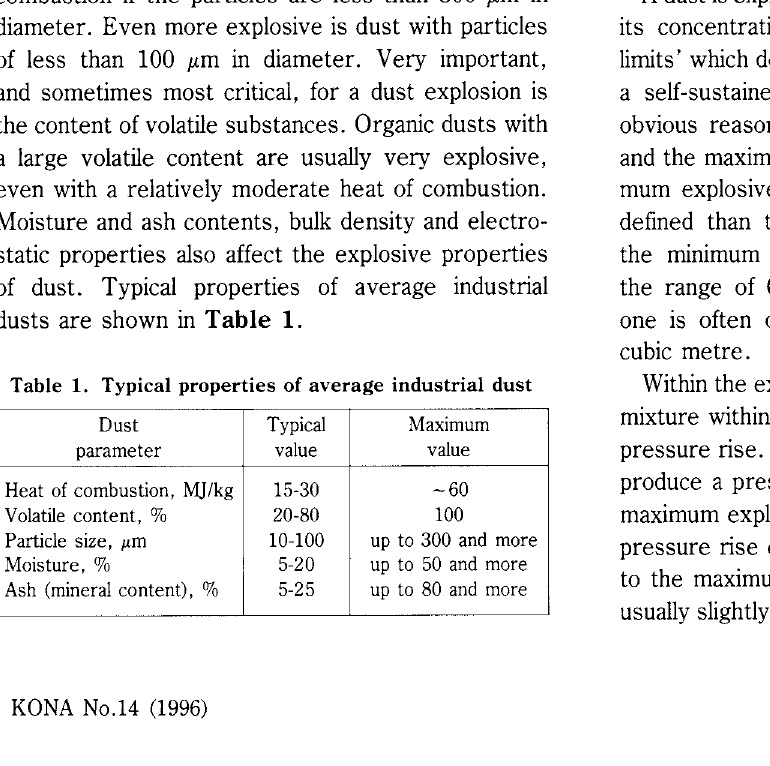
Table 1. Typical properties of average industrial